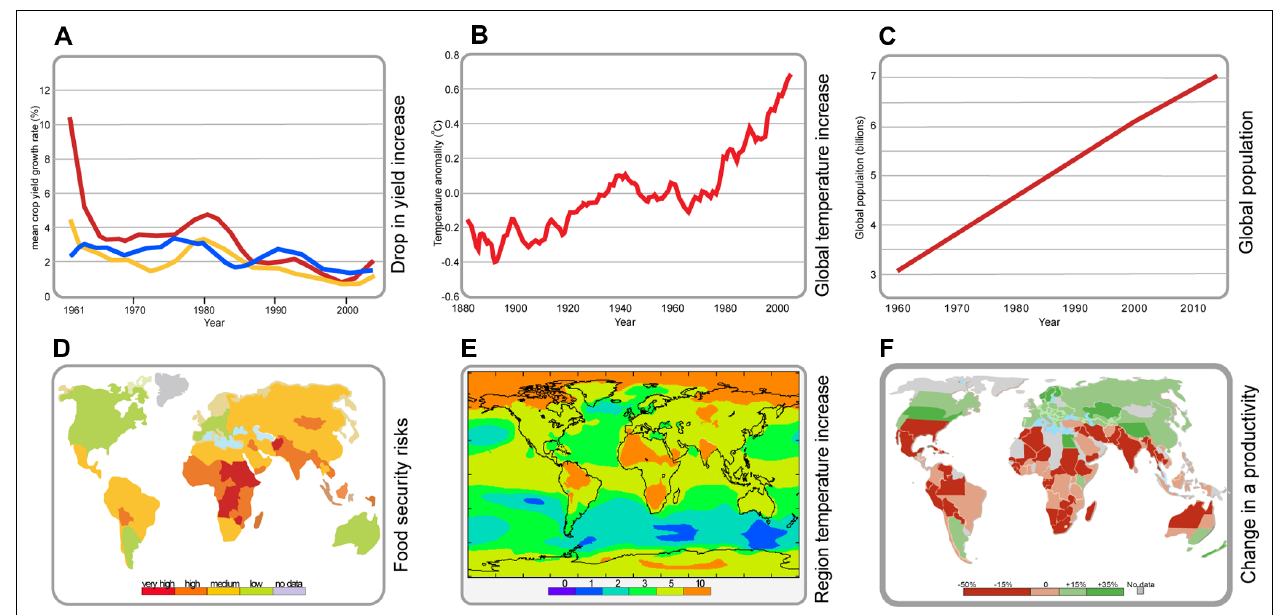
Bureau (http://www.census.gov). (D) Regional food security risk areas. Data taken from http://maplecroft.com (E) Regional temperature increase. Data taken from the Hadely Centre, UK Met Office (http://www.metoffice.gov.uk). (F) Changes in regional agricultural productivity. Data taken from the Bard Center for Environmental Policy